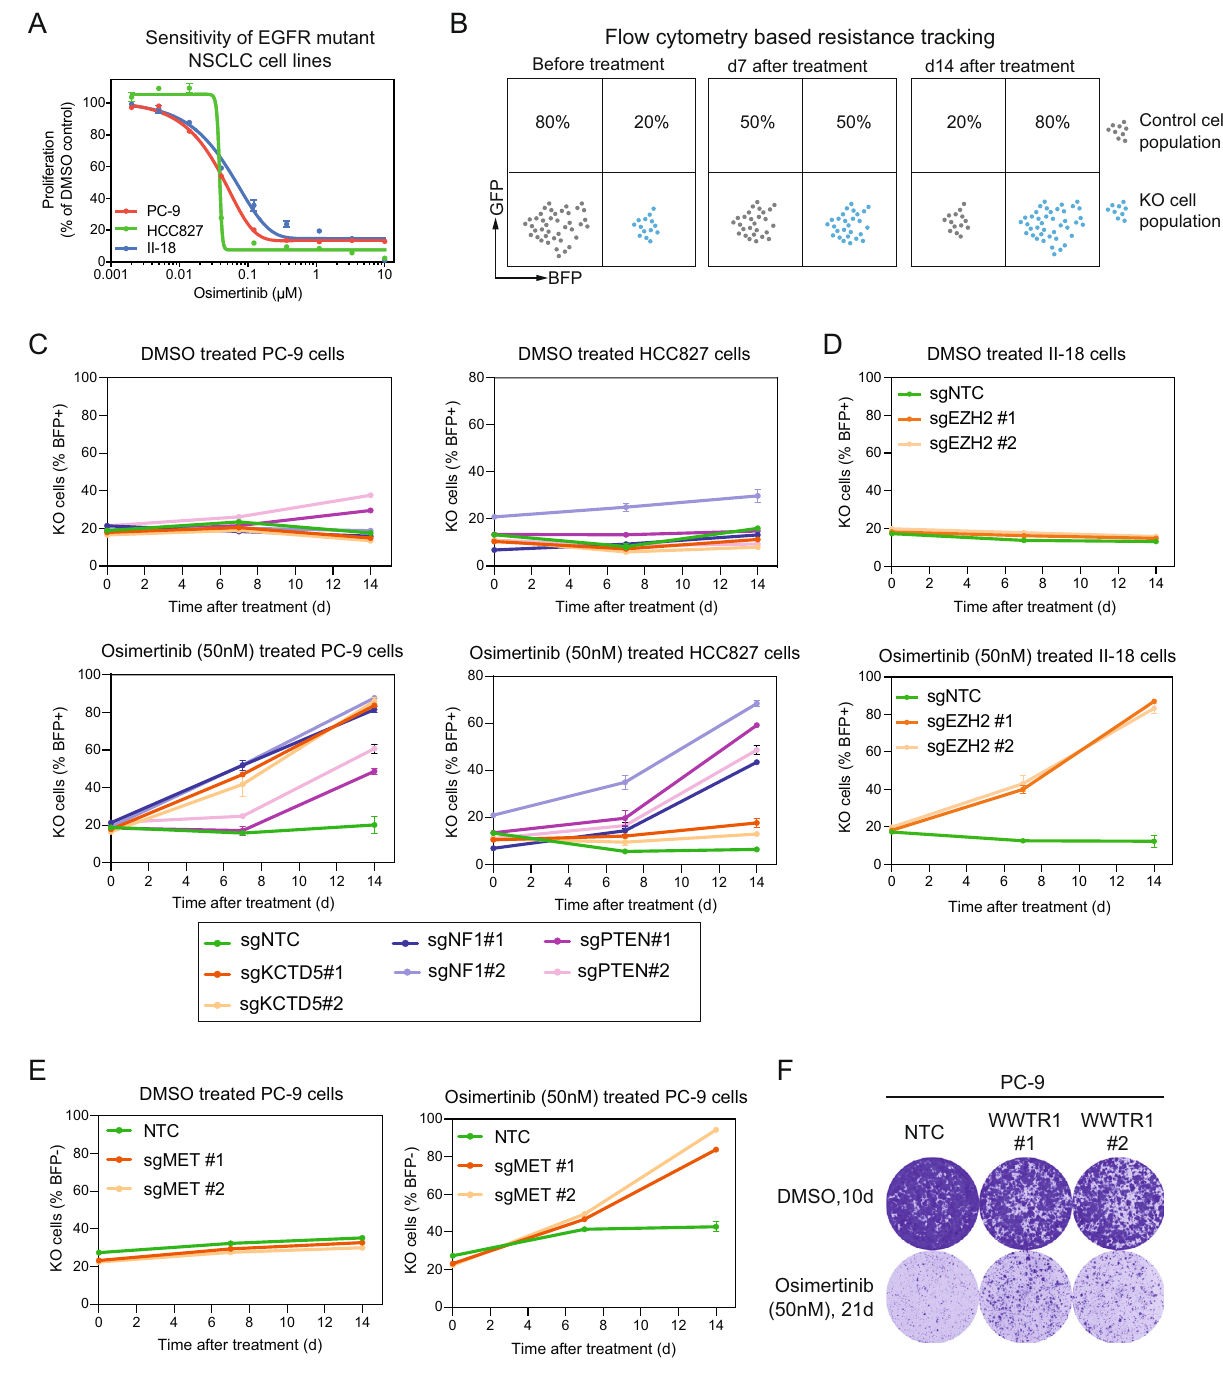
Fig. 5 Validation of resistance genes proposed by recommendation system. A Proliferation assays con fi rm osimertinib sensitivity of EGFR-mutant NSCLC cell lines PC-9, II-18 and HCC827. Data are presented as mean values + / – SD, n = 2 technical replicates, representative data of three biological replicates. B Resistance to osimertinib by target gene KO was measured in fl ow cytometry-based competition assays. Increase in percentage of KO cells compared to control cells was considered as resistance effect to osimertinib. C , D Con fi rmation of resistance to osimertinib in EGFR mutant NSCLC KO cell line models. Effect of KO of genes (EZH2, KCTD5, NF1 and PTEN) on osimertinib resistance was tested in II-18, PC-9 and HCC827 cell lines. Proliferation of cells in DMSO or osimertinib (50 nM) was tracked over 14 days and percentage of BFP + KO cells was plotted. E Activation of MET drives resistance to osimertinib in EGFR mutant PC-9. Cells were engineered to express the dCas9-VP64 SAM CRISPR for MET activation. For C – E , use of two independent guide RNAs per gene were considered as biological replicates ( n = 2), three technical replicates are visualized. Data are presented as mean values + / – SD. F Activation of WWTR1 drives resistance to osimertinib in EGFR mutant PC-9 cells as measured in 21 day clonogenic assays. PC-9 cells were engineered to express the dCas9-VP64 SAM CRISPR for WWTR1 activation. Data presented as mean values + / – SD, representative data of two biological replicates, each consisting of technical duplicates 96